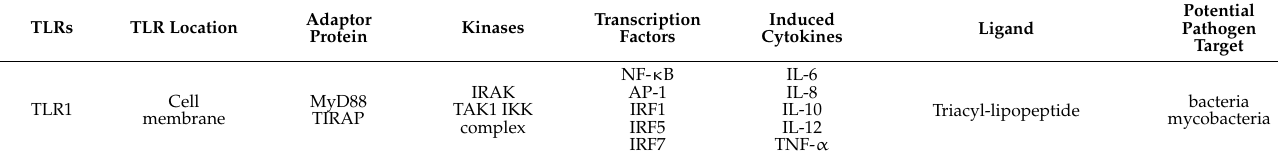
Table 1. Overview and general characteristics of human toll-like receptors